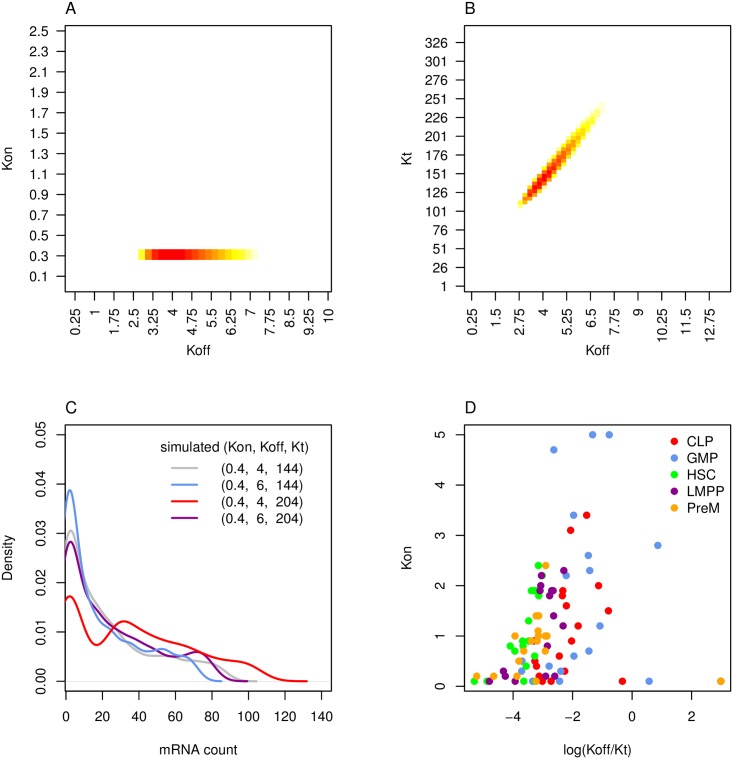
Properties of two-state model and kinetic parameter estimation strategy.Kinetic parameters control the shape of the gene expression distribution. Kinetic parameters are estimated by calculating the maximum likelihood from Eq 2. (A-B) In order to illustrate some properties of the two-state model, the likelihoods of various kinetic parameter sets were calculated for a toy example–specifically GFI1b gene expression data in hematopoietic stem cells (HSC). (A) For each possible Kon and Koff value, we calculated the maximum log likelihood across all possible Kt values. The overall log-maximum likelihood was 603.66 and only values that were within 0.5 of this value were coloured in, with the maximum value in dark red. (B) The maximum log likelihood of all possible Kon values were also calculated, as Koff and Kt were varied. There is a region in subfigure B where Koff and Kt can compensate for one another. (C) An example of parameter compensation was simulated: the original distribution (grey) has visible changes when Koff (blue) and Kt (red) are varied, but the distributions are barely distinguishable when both parameters are varied (purple). (D) Finally, we show our method’s estimates of Kon and ln(Koff/Kt) for each TF in each population of FACS cells.